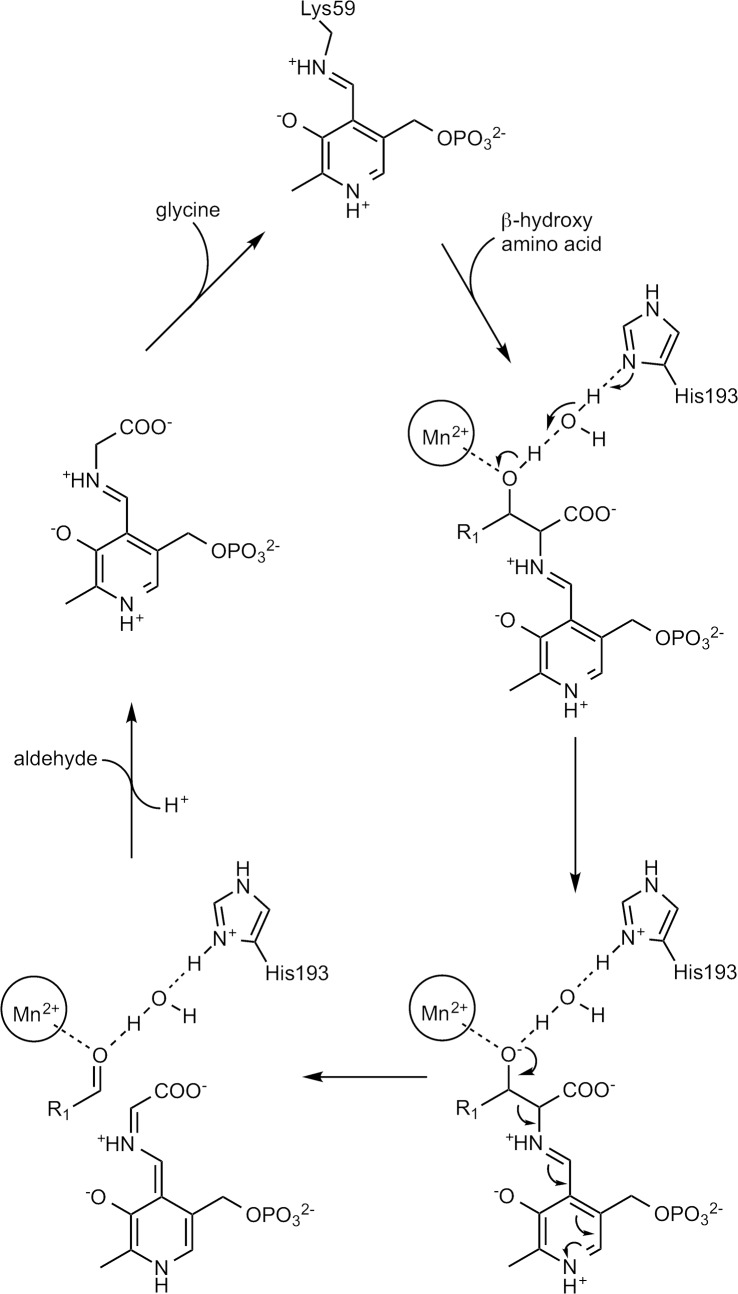
Proposed catalytic mechanism of AxDTA.